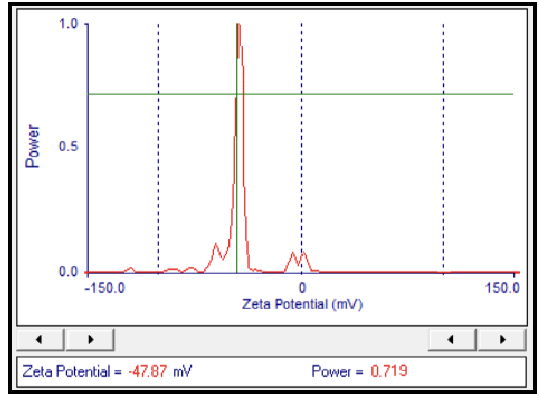
Figure 15. Zetapotential monograph of the